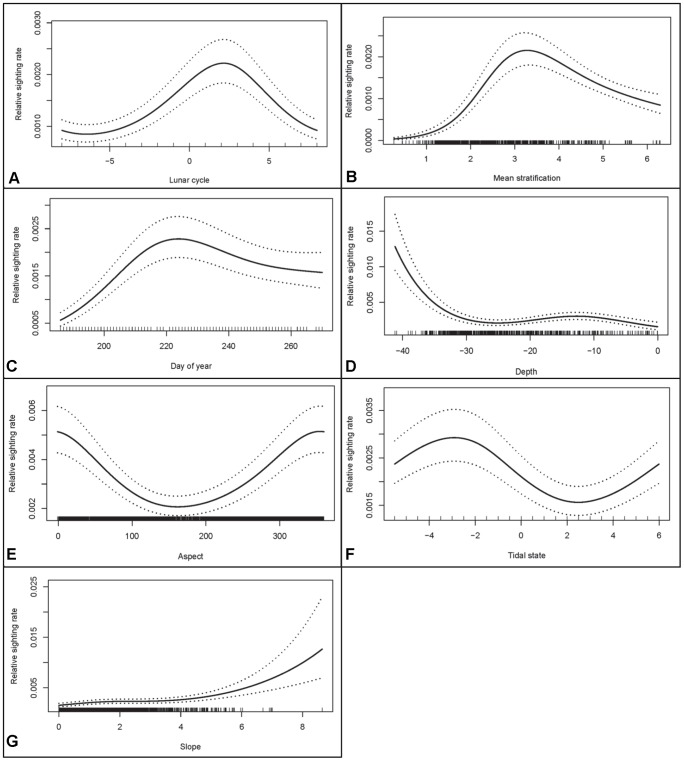
The estimated effect of environmental covariates on the observed harbour porpoise sighting rate.Predictions were made by varying the variable of interest (e.g. Lunar cycle in the first figure), but keeping the other values fixed at median values at which they occur in the model data.